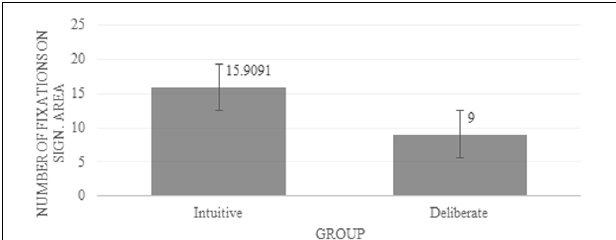
FIGURE 4 | Average number of fixations on the significant area. Error bars indicate standard error.